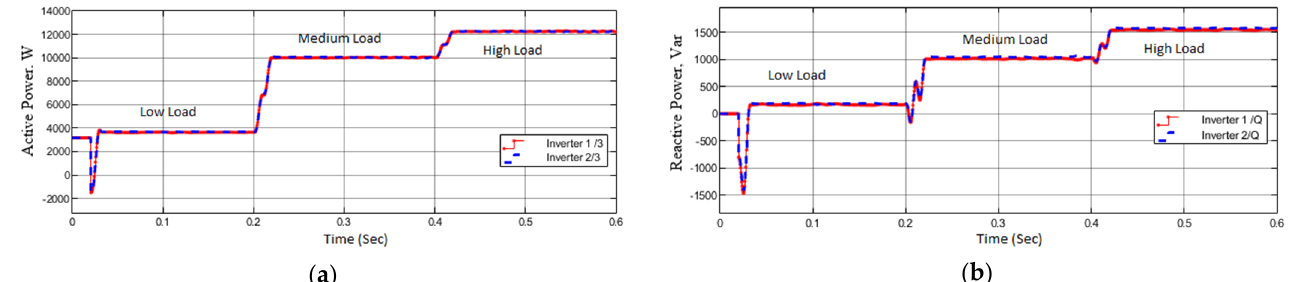
Figure 20. Output power of the inverter when low, medium, and high loads are supplied using ABC droop control for: ( a ) Active power; ( b ) Reactive power. droop control for: ( a ) Active power; ( b ) Reactive